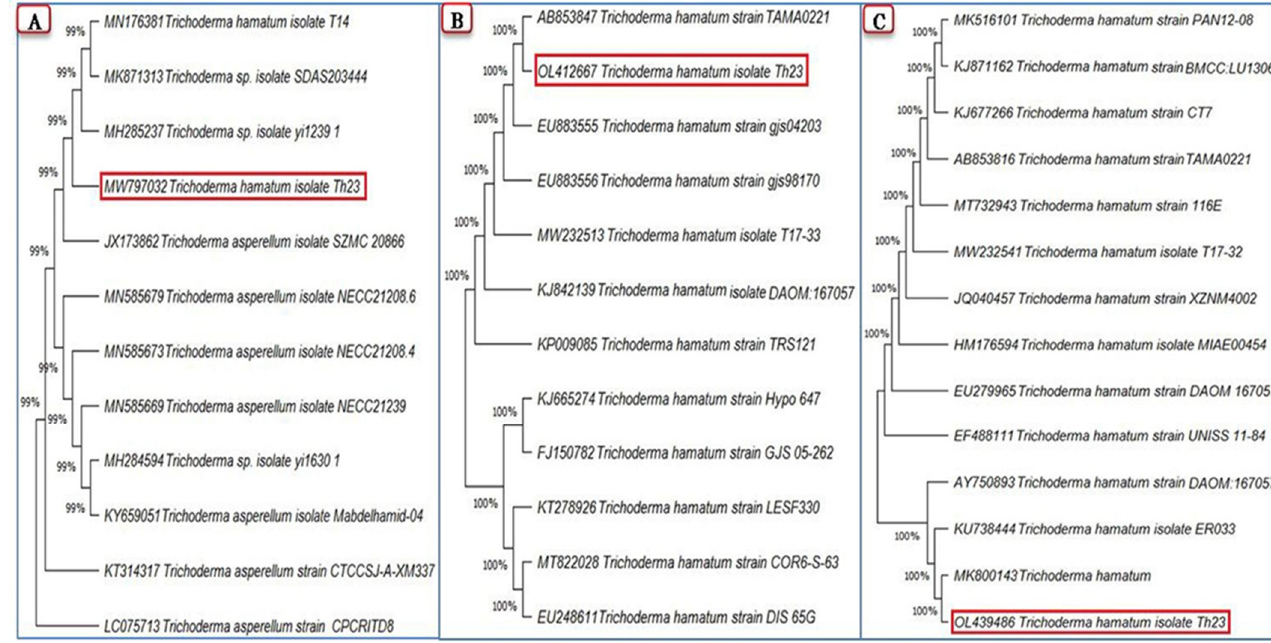
Figure 1. Phylogenetic trees show the relationship of the Trichoderma hamatum strain Th23 (shown in a red rectangle) among closely related Trichoderma isolates from GenBank based on partial sequences of three genes: ITS ( A ), rpb2 ( B ), and tef1 ( C ) generated by MEGA X software.